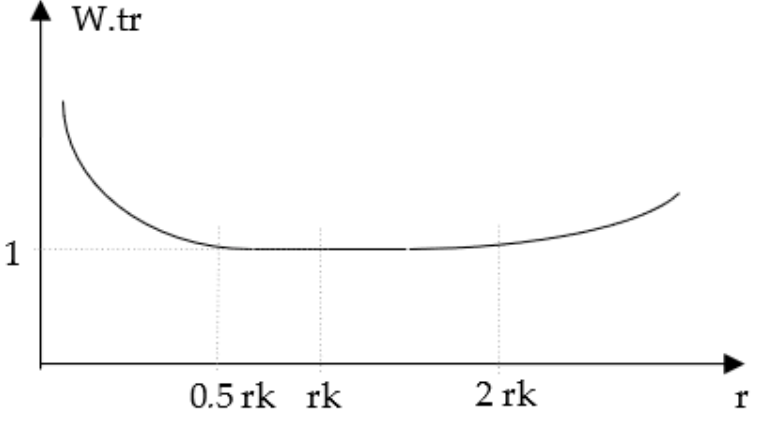
Figure 2. Dependence of the coefficient of difficulty on the radius of the travelled curve (rk-design radius of the radius of the ski).